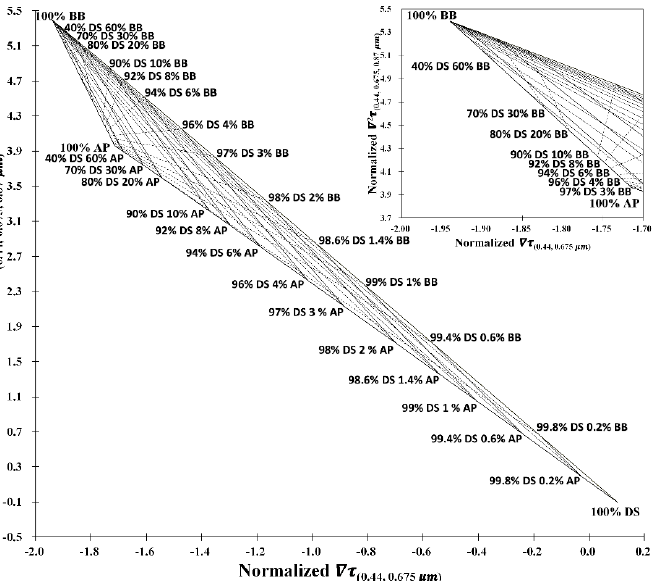
Figure 10. The second–order derivative ( ∇ 2 τ with 0.44, 0.675 and 0.87 μ m related to the refractive index) against the first–order derivative ( ∇ τ with 0.44 and 0.675 μ m related to size distribution) normalized by AOD (0.47 μ m) simulated with a step of 0.01 from 0.00 to 1.00 when mixing the weights of volume density from the 6S model for triple–component mixtures (i.e., DS, AP and BB aerosols).